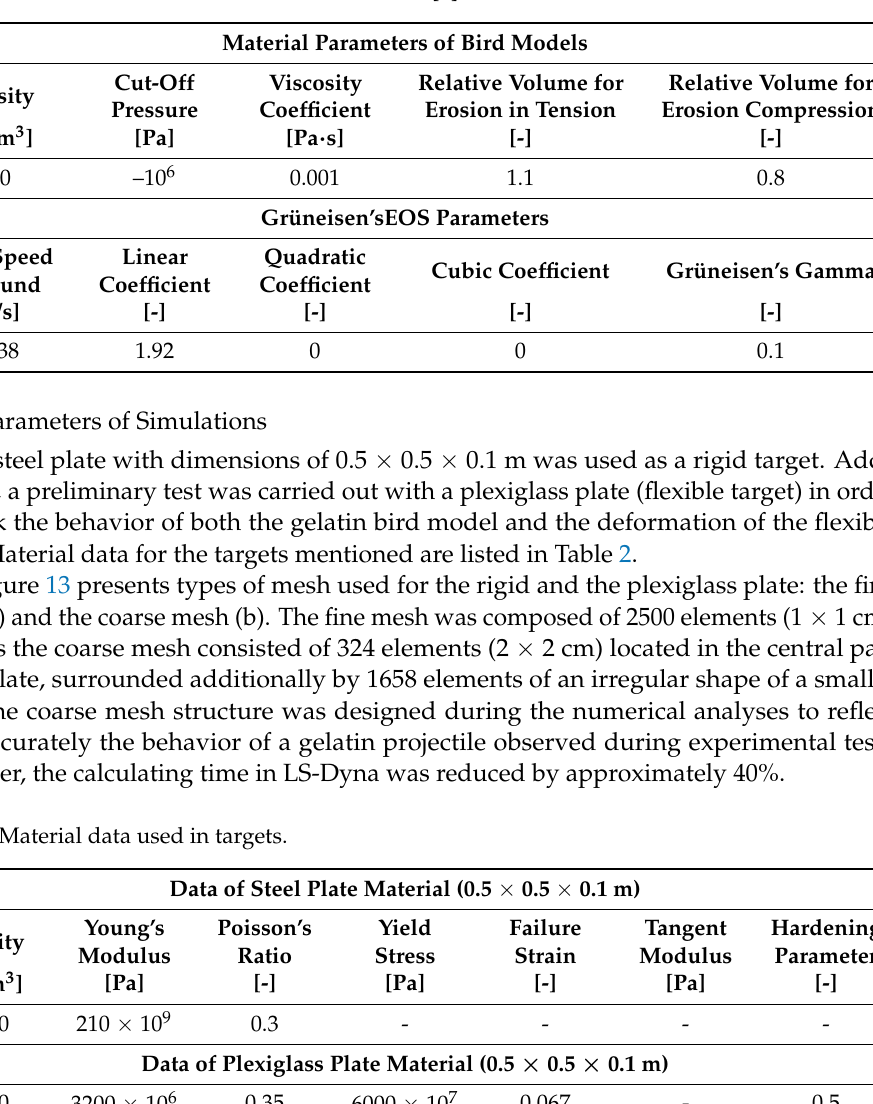
Figure 12. SPH bird models with different pitch value: ( a ) 3 mm; ( b ) 5 mm.